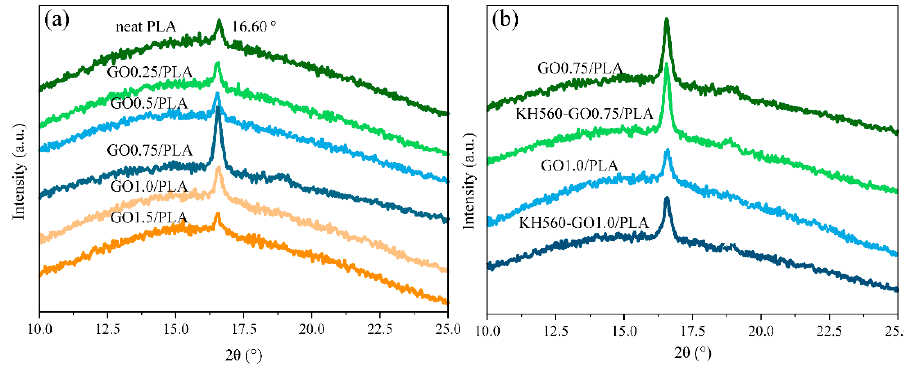
Figure 3. XRD curves of ( a ) GO/PLA and ( b ) KH560-GO/PLA nanocomposites.